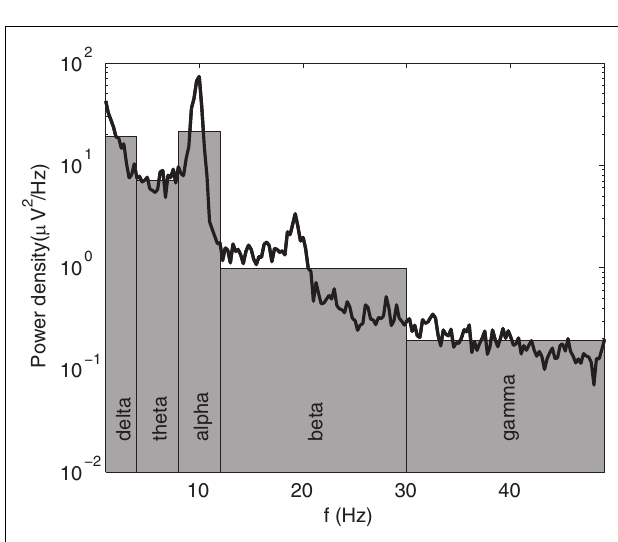
FIGURE 1 | Example of an EEG spectrum (black line) with its qEEG approximation in terms of band powers, given by the areas of the gray